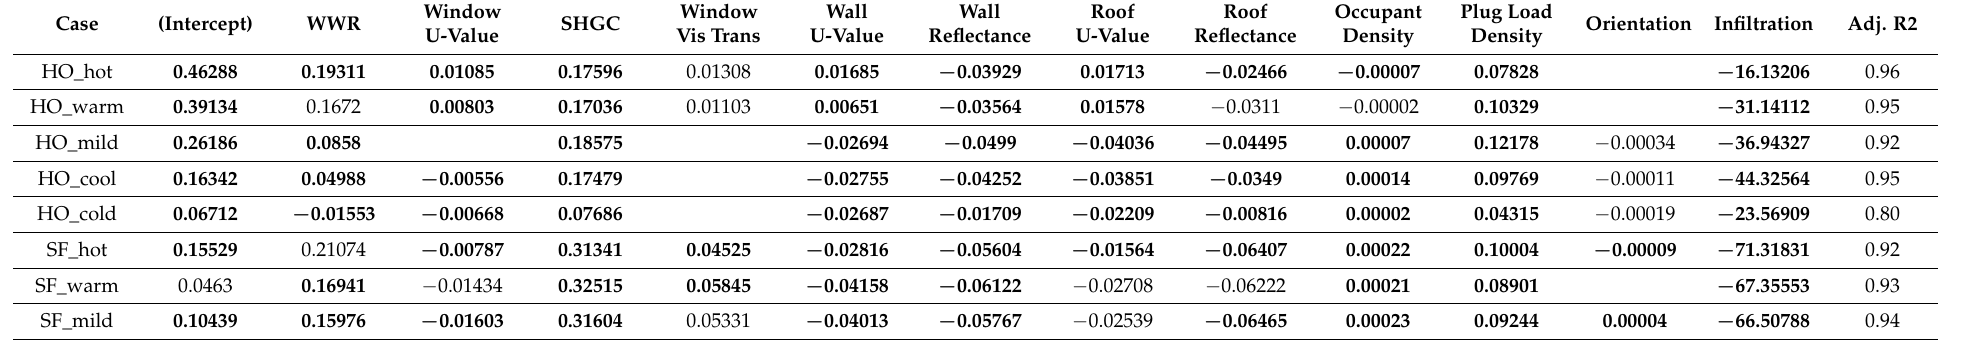
Table A2. Thermal OHL Regression